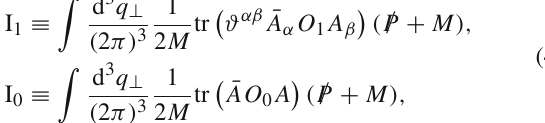
+ ( bcq ) the corresponding states of the inside ( bc ) -diquarks. Type I 2 ) are used to describe J